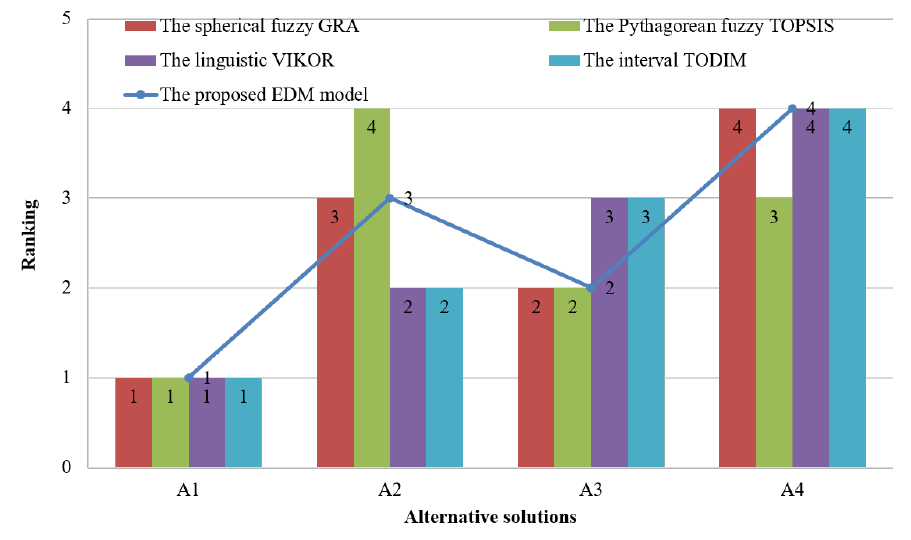
Figure 2. Ranking results by the listed EDM methods.